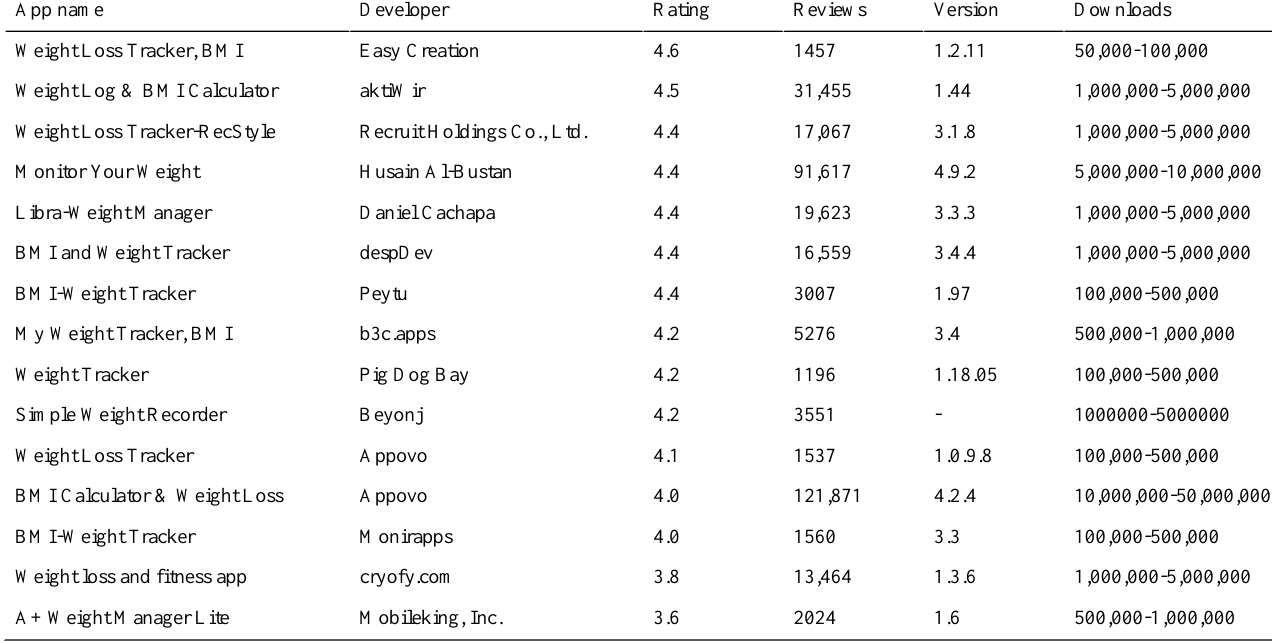
Table 4. Basic information about the 15 weight-tracking apps.